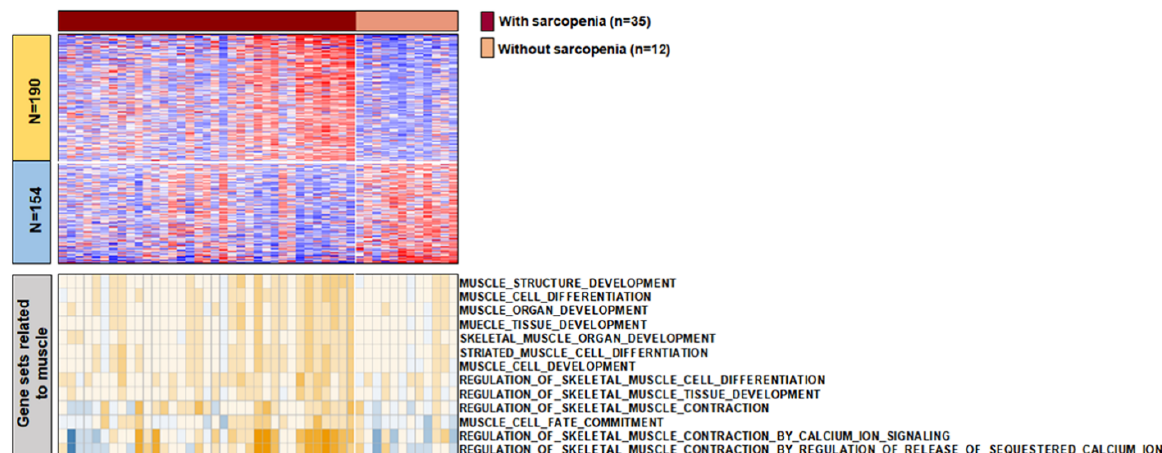
Figure 4. The heatmaps for transcriptomic features of primary tumors according to the presence of sarcopenia. Differentially expressed genes demonstrated between samples with and without sarcopenia (top). Single sample gene set enrichment analysis of 13 muscle-related gene sets in samples with and without sarcopenia (bottom).